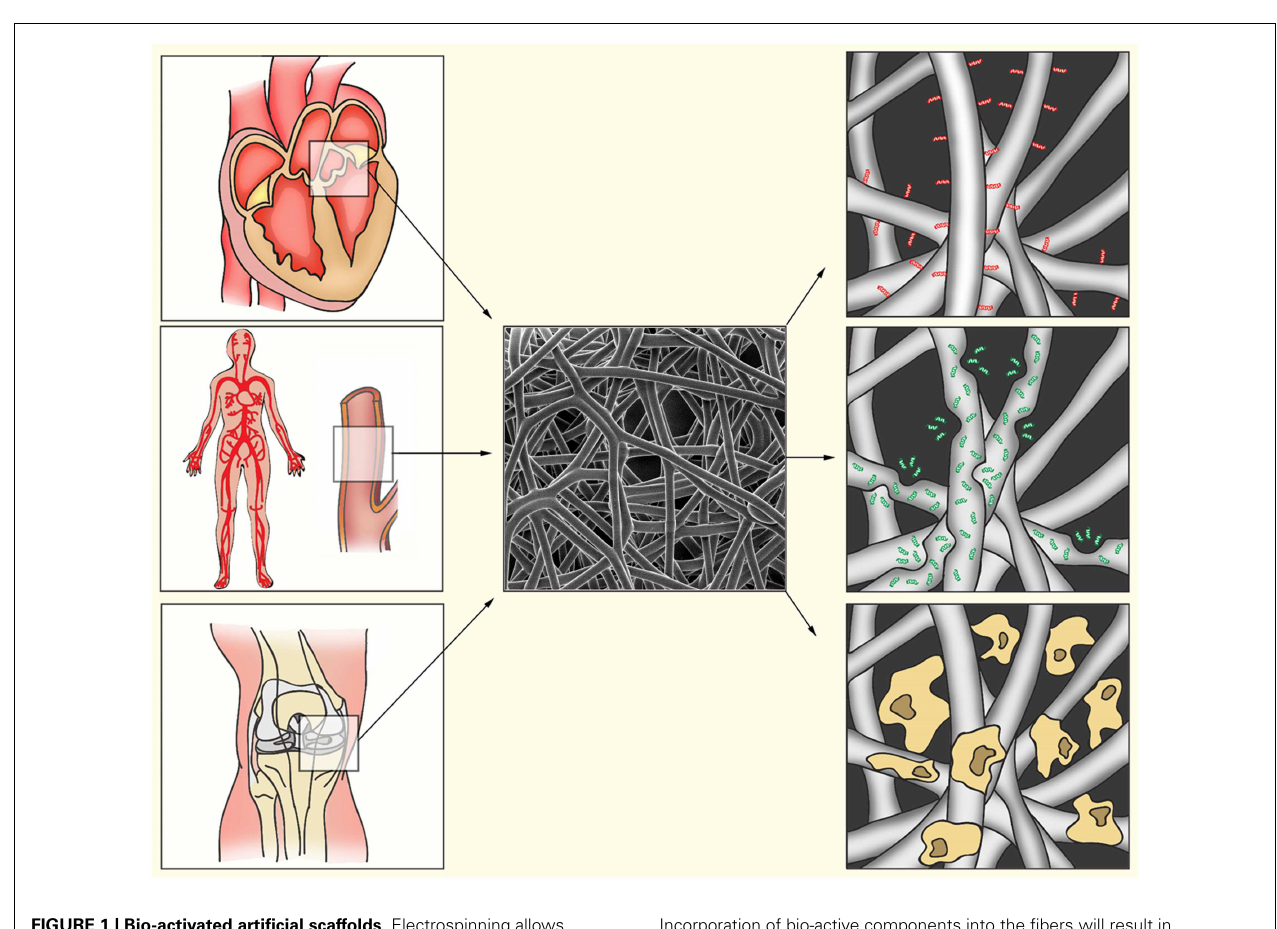
FIGURE 1 | Bio-activated artificial scaffolds . Electrospinning allows formation of constructs with a variety in shapes, sizes, and tissue strength.This allows the production of constructs for a variety of tissues (left). Electrospun fibers (middle) can be bio-activated by coating of the fibers with proteins or peptides (right,